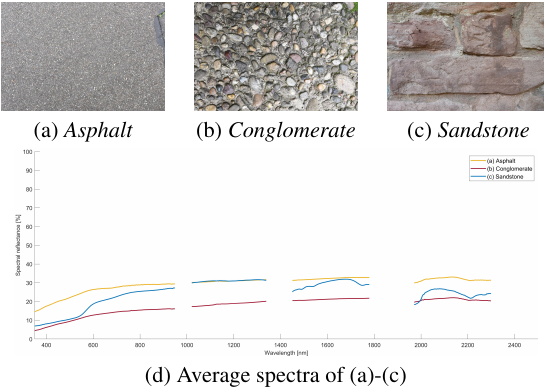
Figure 2. Imagery from the extended KLUM library; (a) Asphalt , (b) Conglomerate and (c) Sandstone , and the corresponding av- erage spectra (d).